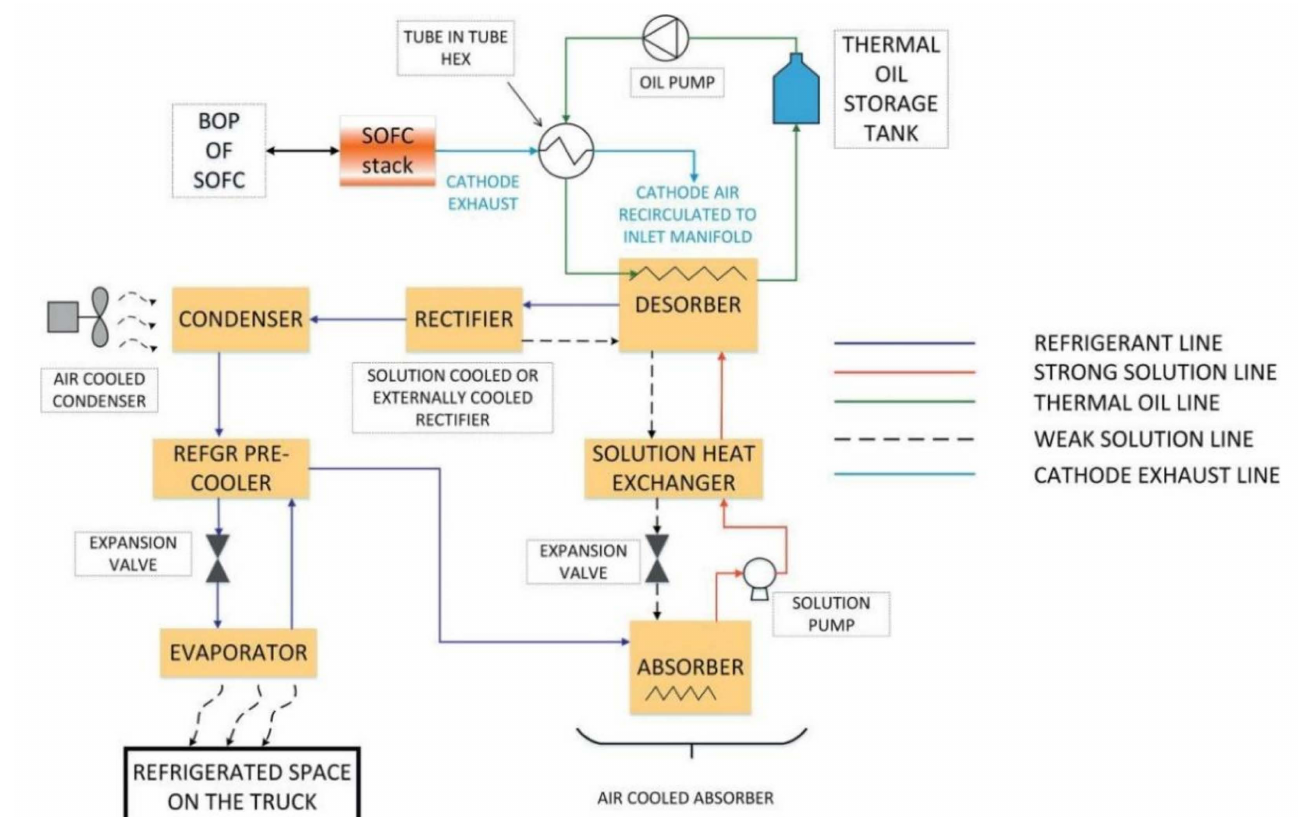
Figure 15. Schematic diagram of solid oxide fuel cell coupled with absorption refrigeration system. Reprinted with permission from ref. [55], Copyright